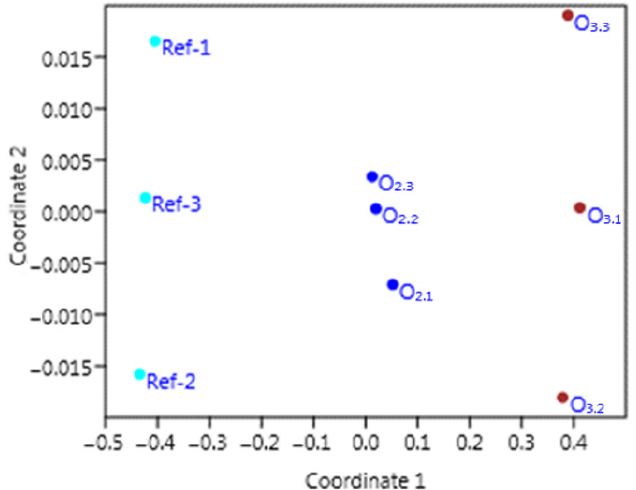
Figure 14. Multidimensional scaling results of effects of adding the water with O 2 and O 3 micro- nanobubbles on concrete properties.